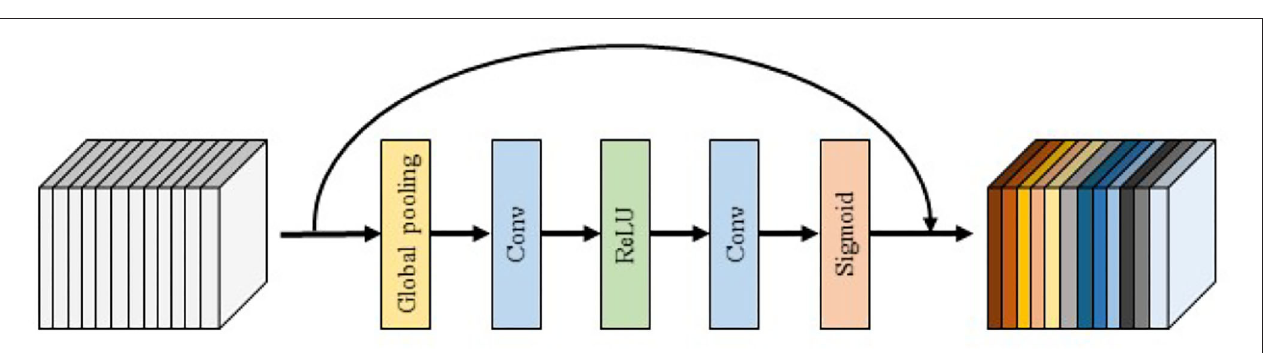
FIGURE 4 | The overall structure of